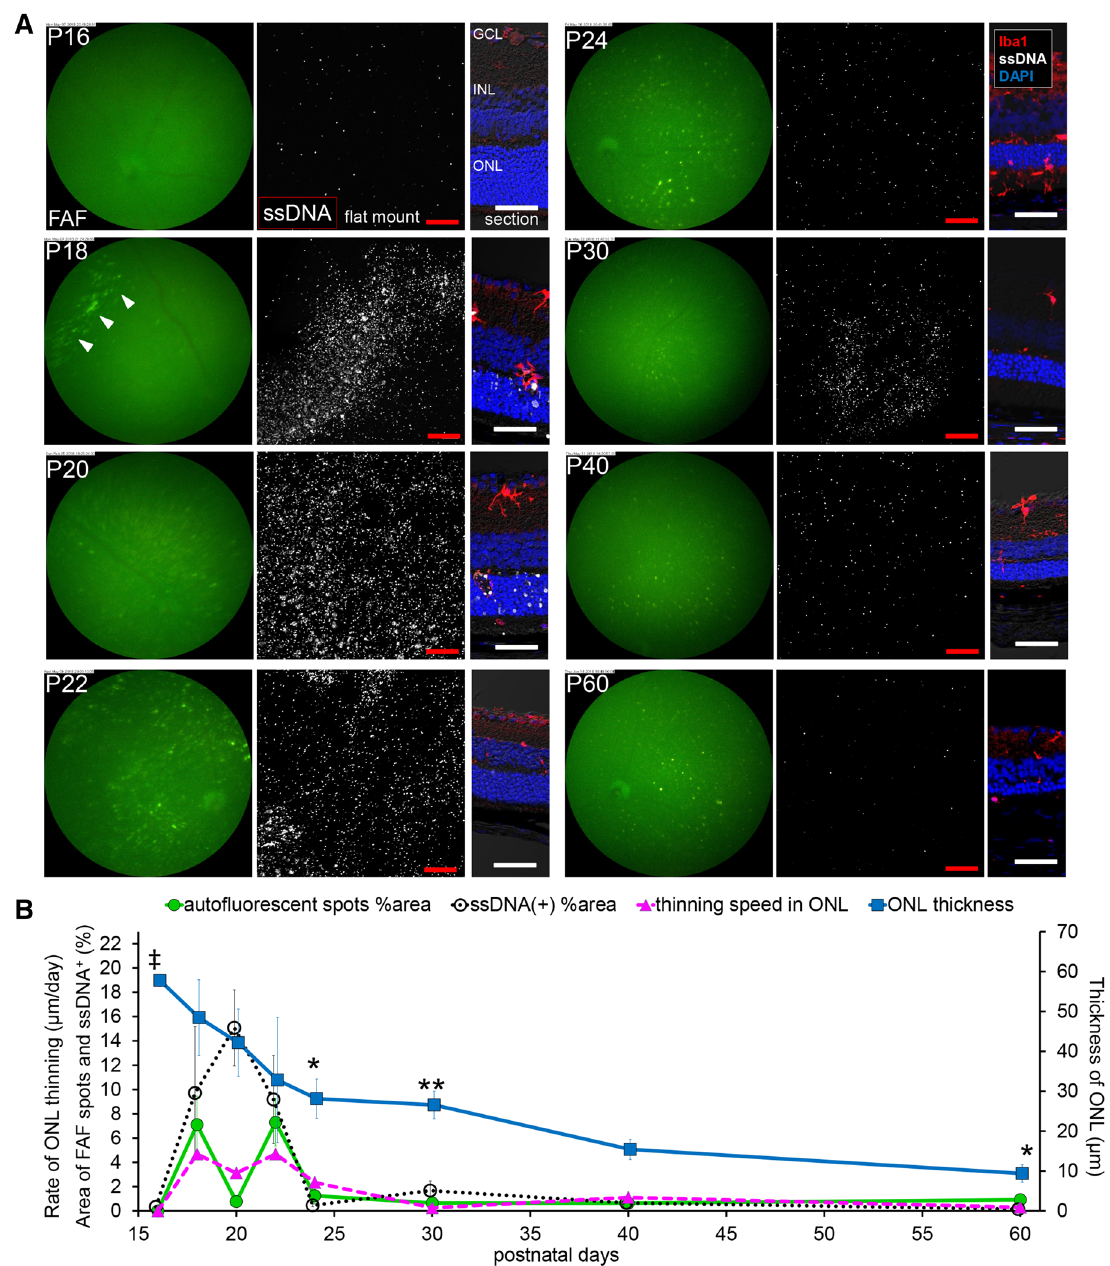
Figure 3. Relationship in fundus autofluorescent spots, apoptosis of photoreceptors and retinal ONL thickness in the peripheral retina of rd10 raised under regular light cycle. ( A ) Pictures show the time course change in the peripheral retina of rd10 from P16 to P60. Left pictures are in vivo FAF imaging with a retinal imaging microscope. Middle pictures show the confocal images of extracted flat-mounted retina at the ONL level, labeled with ssDNA (white). Scale bars, 100 μm. Right pictures show the retinal section labeled with DAPI (blue), ssDNA (white) and Iba1 (red). Scale bars, 50 μm. Arcuate FAF spots emerged on P18 (arrowhead). Arcuate aggregates of ssDNA + cells also emerged on P18, and then subsequently appeared diffusely spread. ( B ) The graphs show the quantification of the FAF spot area % (green line), the ssDNA + area % (black line), the thickness of the ONL (blue line) and thinning rate of the ONL (magenta line). The markers of graph show mean and SD (n = 4). (‡ p < 0.01 (Center > Periphery), * p < 0.05, ** p < 0.01 (Periphery > Center), t test of ONL thickness compared to the central retina). The area of autofluorescent spots showed a bimodal course. The first peak was from arcuate autofluorescent spots and the second peak was from diffuse autofluorescent spots. The bimodal peaks of the thinning rate of the ONL and the bimodal peaks of the FAF spot area were observed synchronously on P18 and